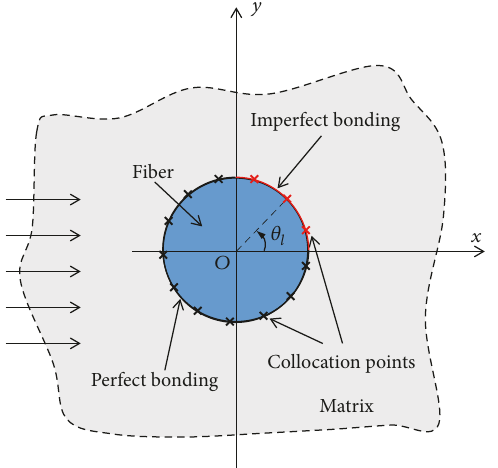
Figure 2: Distribution of CPs denoted by “ × ” symbol. It is noted that at least one CP should be distributed on the imperfectly bonded interface as long as 𝛽 is not equal to 0. In this figure, = 𝜋/4𝛽 = 𝜋/2 , and 𝑛 max = 6.